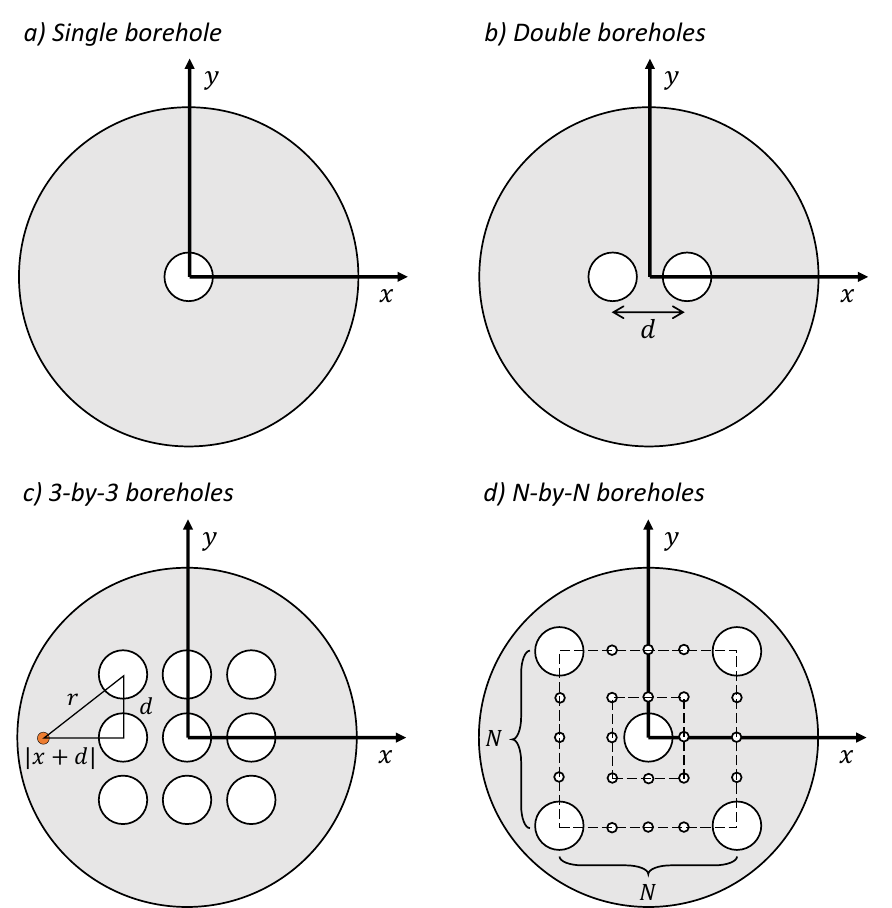
Figure 2. Schematic diagram of different scenarios of borehole systems: ( a ) single borehole; ( b ) double boreholes; ( c ) 3-by-3 boreholes; and ( d ) N-by-N